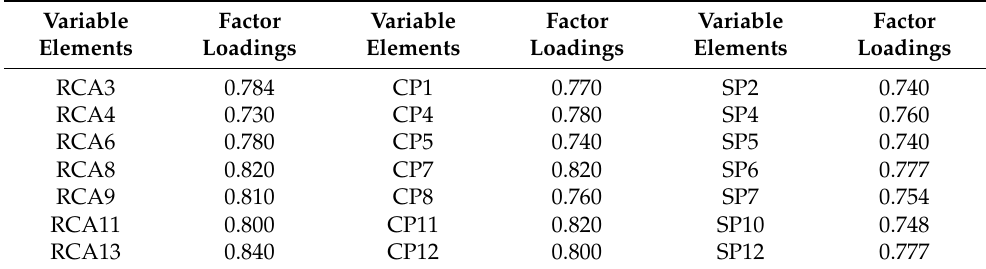
Table 3. Factor analysis